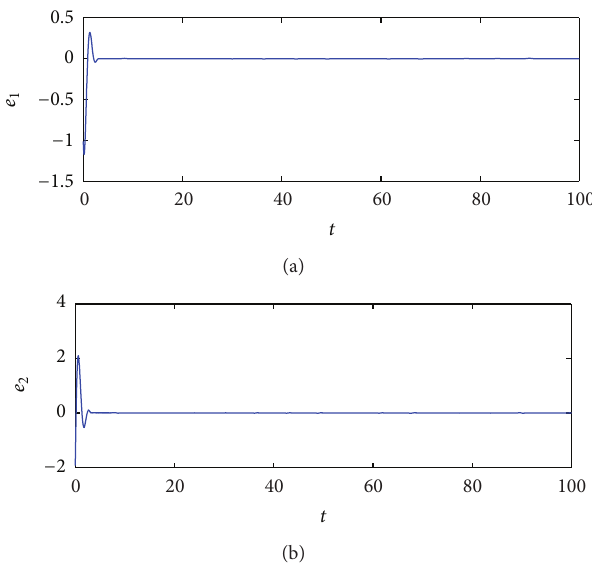
Figure 3: Synchronization error between fractional-order Duffing- Holmes systems (25) and (26).